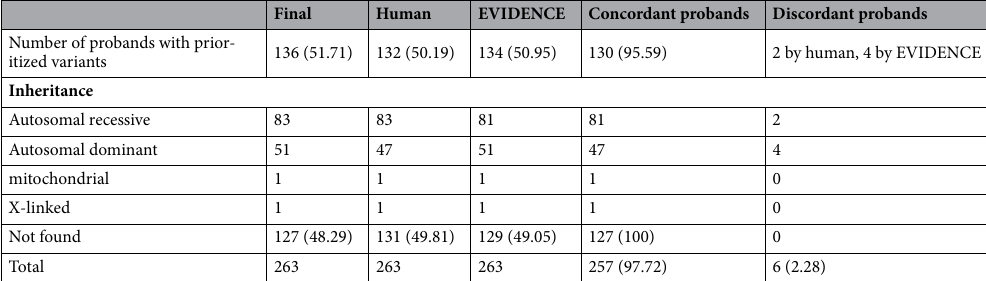
Table 1. Final variant interpretation results of cohort probands (n